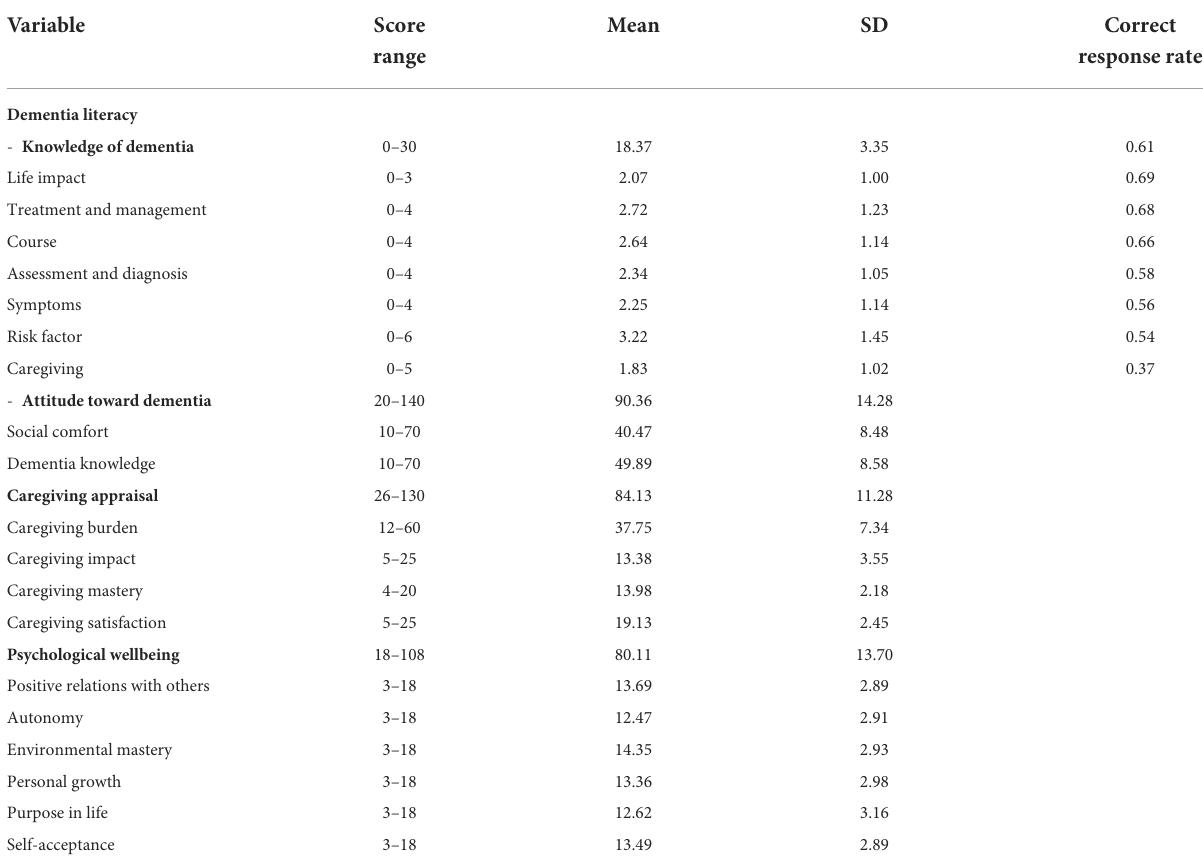
TABLE 1 Means and standard deviation of the study variables ( n = 223). Variable Score